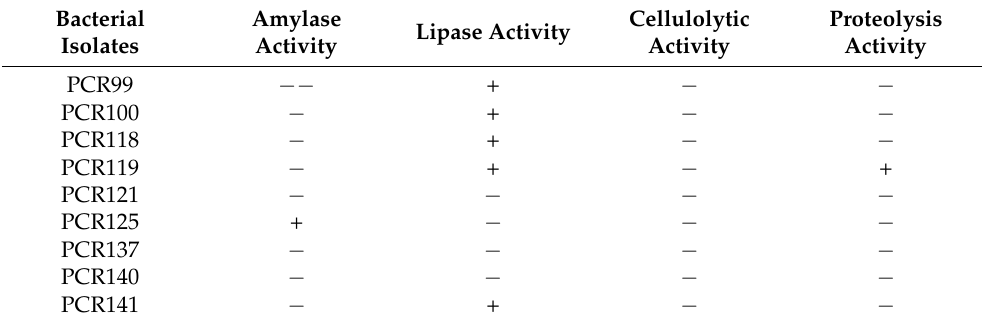
Table 1. Determination of Enzymatic Potential of Selected Lactobacillus Strains. Bacterial